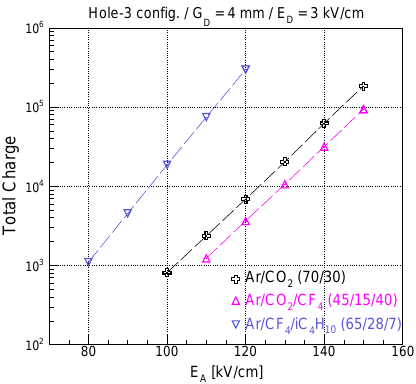
Figure 8. Gain for different gas